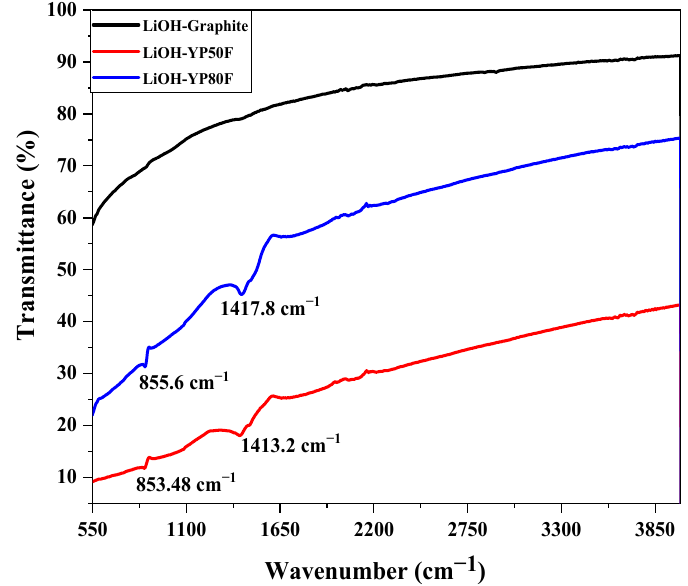
Figure 5. FTIR spectra of LiOH-treated YP80F, YP50F and graphite. Table 2. According to the summary results of BET and BJH, the surface area and total pore mass (mesopore and micropore) of the graphite was increased after the LiOH treatment, whereas the values were decreased for the bare-YP50F and YP80F. In the calculation of the t- plot, the total surface area of Li-YP50F was 43.5 m 2 /g and of Li-YP80F was 1063.2 m 2 /g. The micropore volume of Li-YP80F decreased from 1.084 to 0.511 cm 3 /g, while the